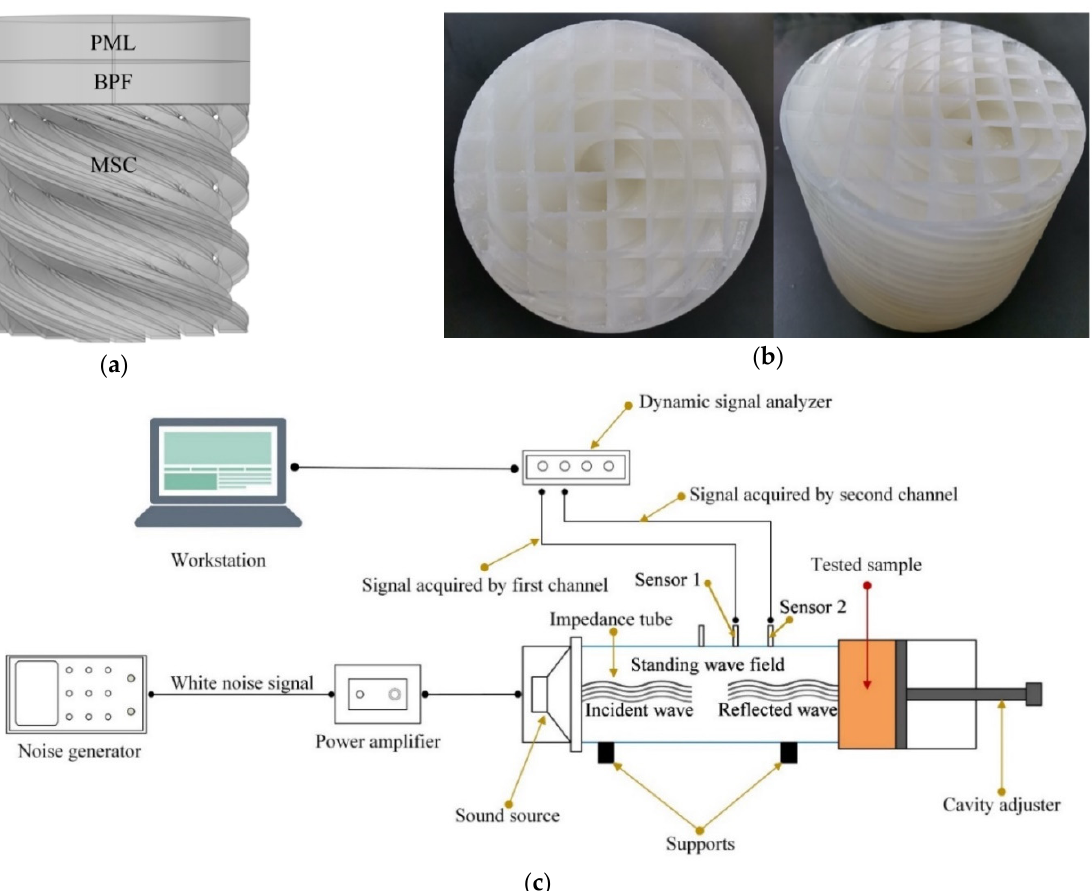
Figure 2. Finite element simulation analysis and experimental validation of sound absorption performance of the MSC-AM. ( a ) Finite element simulation model of the MSC-AM; ( b ) the prepared experimental sample for the MSC-AM; ( c ) schematic diagram of the AWA6290T standing wave tube tester.